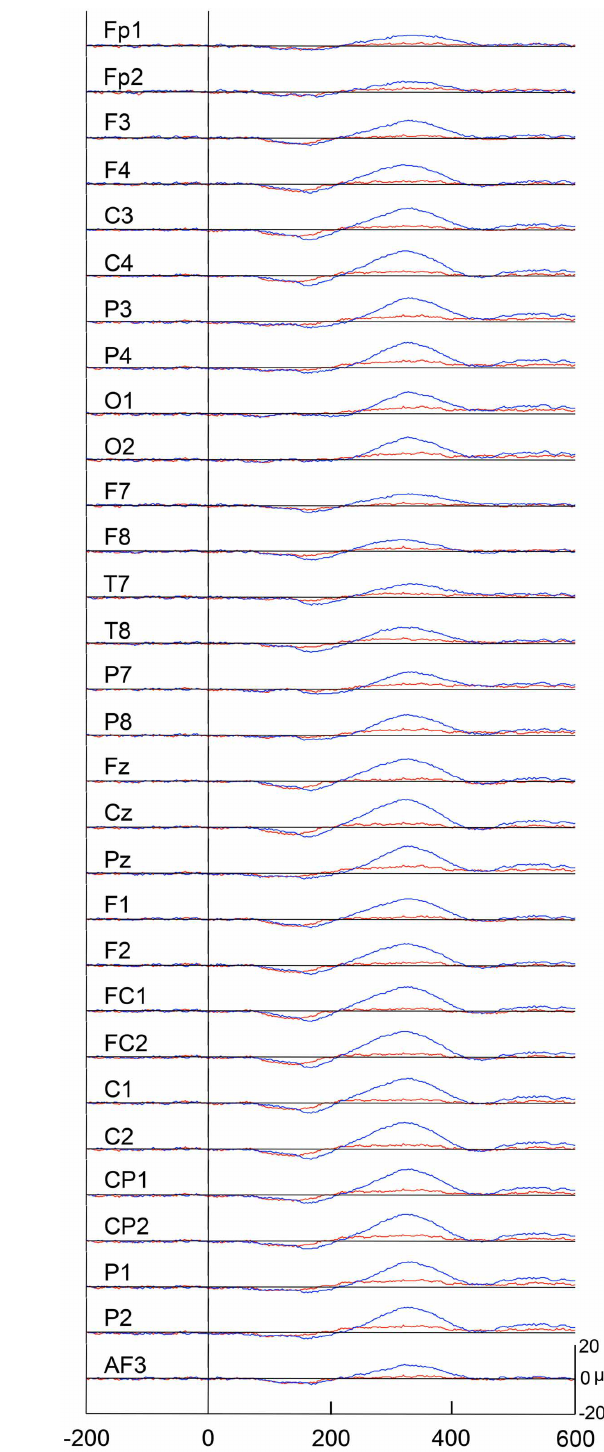
Frontiers in Behavioral